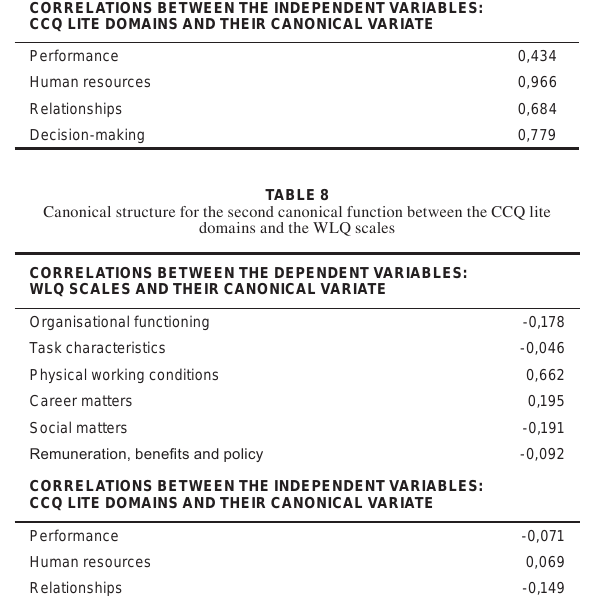
Table 9 CCQ lite